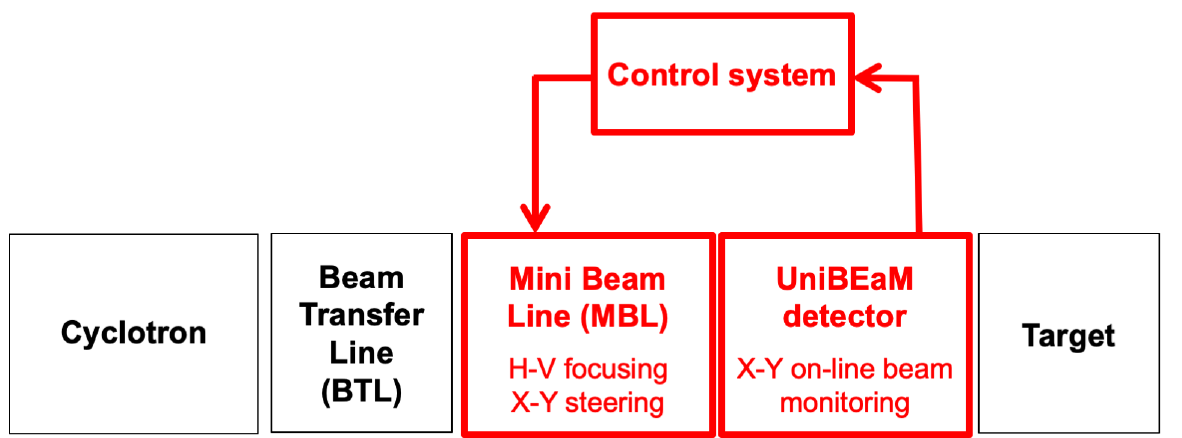
Figure 3. Scheme of the experimental set-up in which the Automatic Focusing System (AFS) is highlighted in